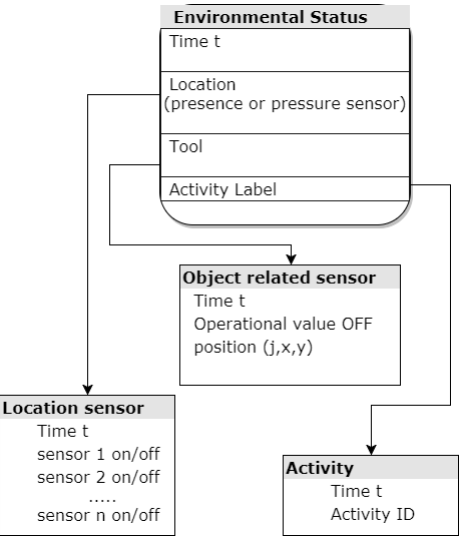
Figure 4: Database structure used to represent the environmental information through sensory data. The environmental status is composed by the instance of location , tool , and the Activity label classes in a given time t . The location class has the information regarding all sensors used to find the user current location. The tool class, works as any objects used to perform the activities. The activity class has information regarding which activities are been accomplished during the given time t